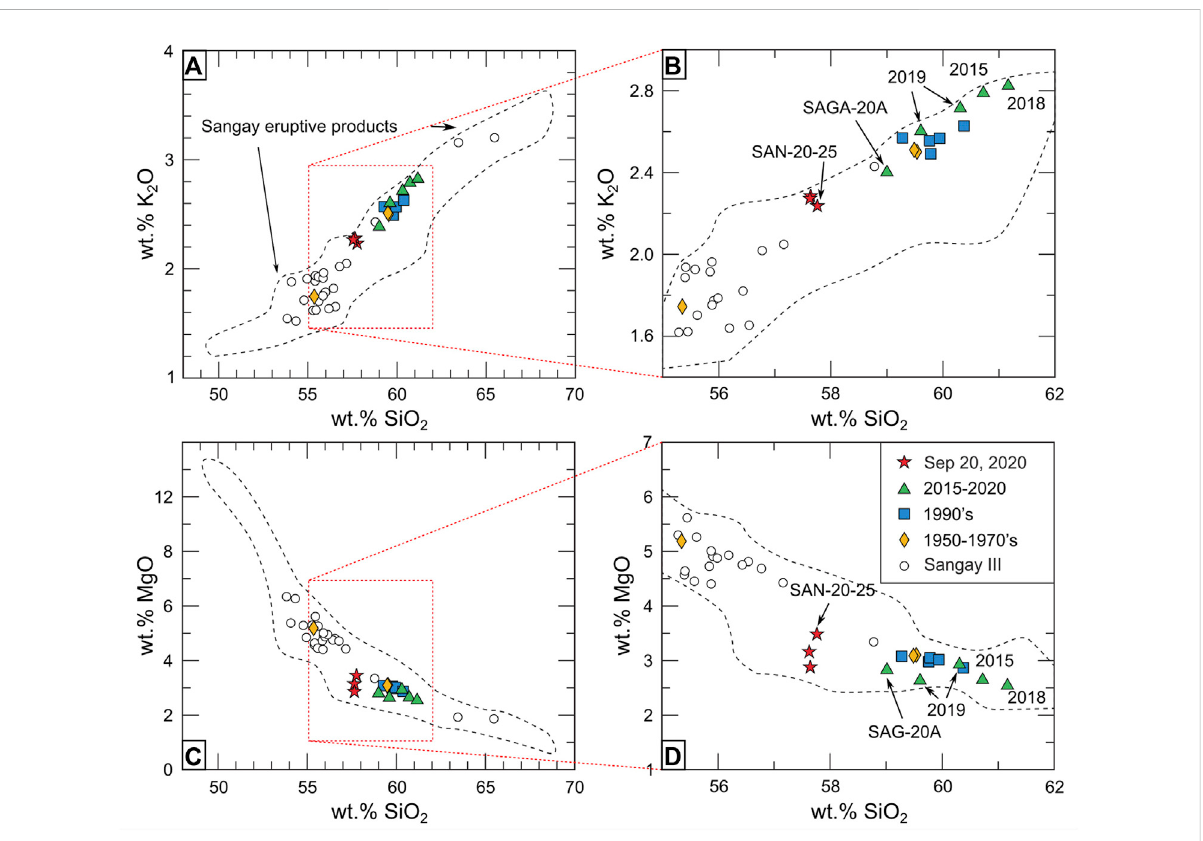
FIGURE 9 Major element composition of September 20, 2020 ash samples compared to previous data from Monzier et al. (1999) and Vasconez et al. (2022). (A) K 2 OvsSiO 2 diagram; (B) Zoom on (A) showingtherecentproducts compositions; (C) MgO vsSiO 2 diagram; (D) zoom on (C) showingthe recent products compositions. Analytical error is smaller than the size of the